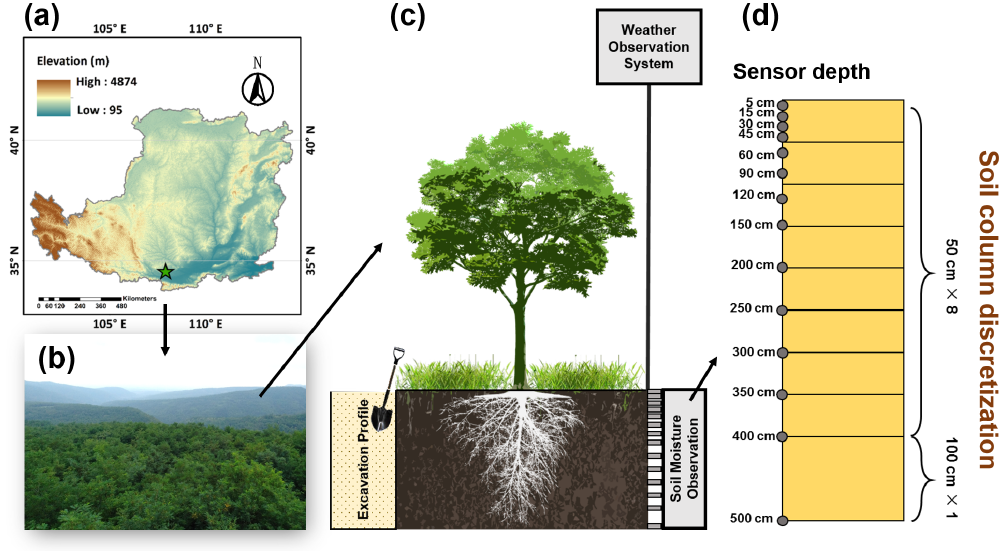
Figure 3. (a) Location of the study site (Yeheshan) in the Loess Plateau, China; (b) top view from the black locust plantation canopy in July 2018; (c) meteorological observation tower, soil moisture observation, and excavation root profile; (d) installation of the soil moisture sensors.